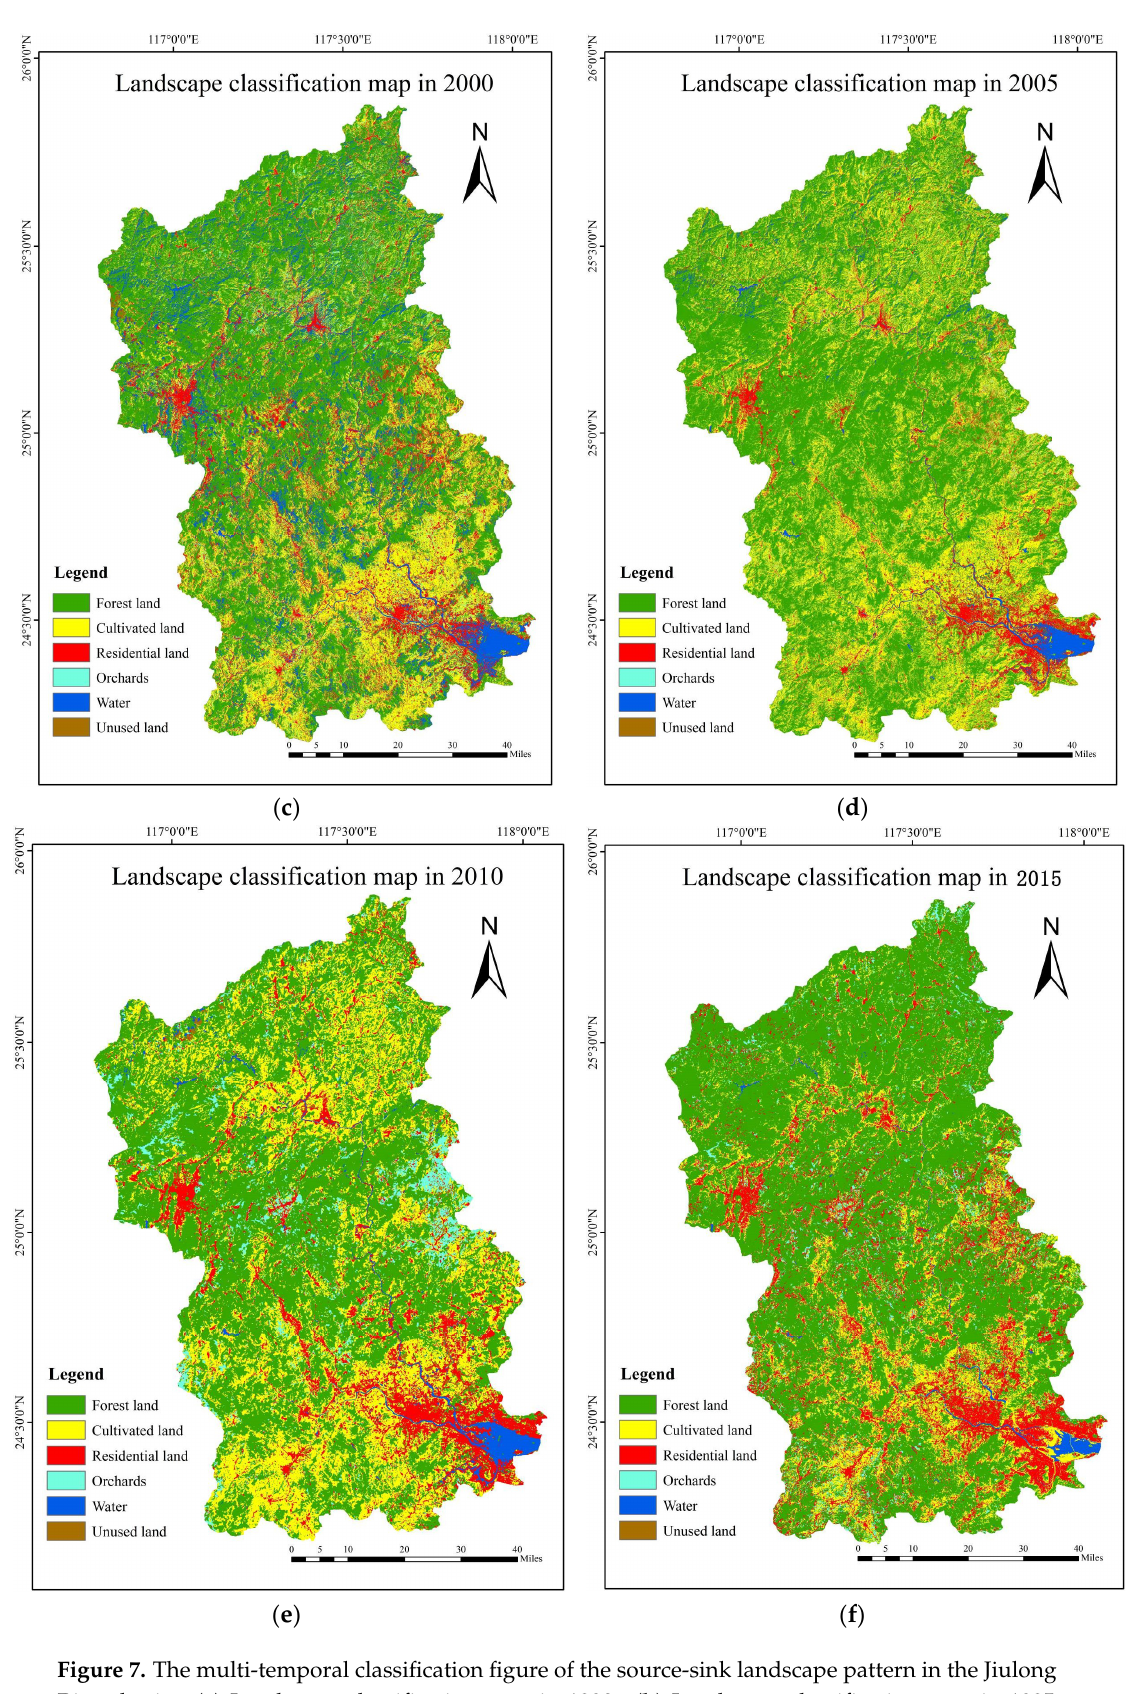
Figure 7. The multi-temporal classification figure of the source-sink landscape pattern in the Jiulong River basin. ( a ) Landscape classification map in 1990. ( b ) Landscape classification map in 1995. ( c ) Landscape classification map in 2000. ( d ) Landscape classification map in 2005. ( e ) Landscape classification map in 2010. ( f ) Landscape classification map in 2015.